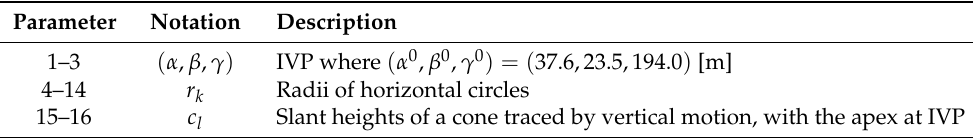
Figure 7. The trace of vertical motion of targets (only two targets are involved). Two targets are located on the opposite sides of the structure under the antenna. Table 2. List of parameters used in this